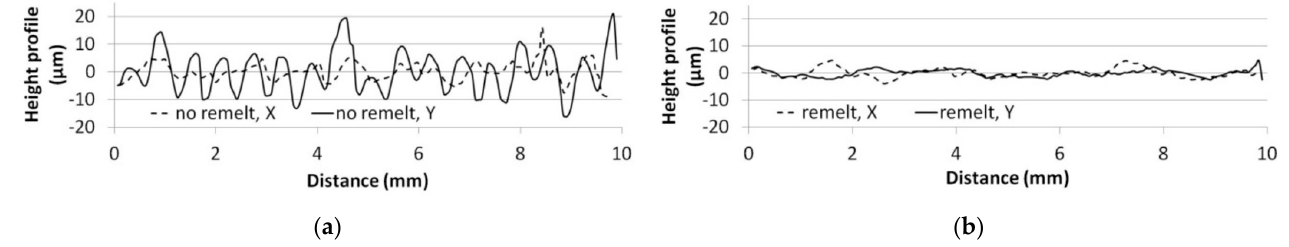
Figure 35. Height profile measured on samples ( a ) without and ( b ) with laser remelting (reproduced with permission from [181]; Copyright © 2013